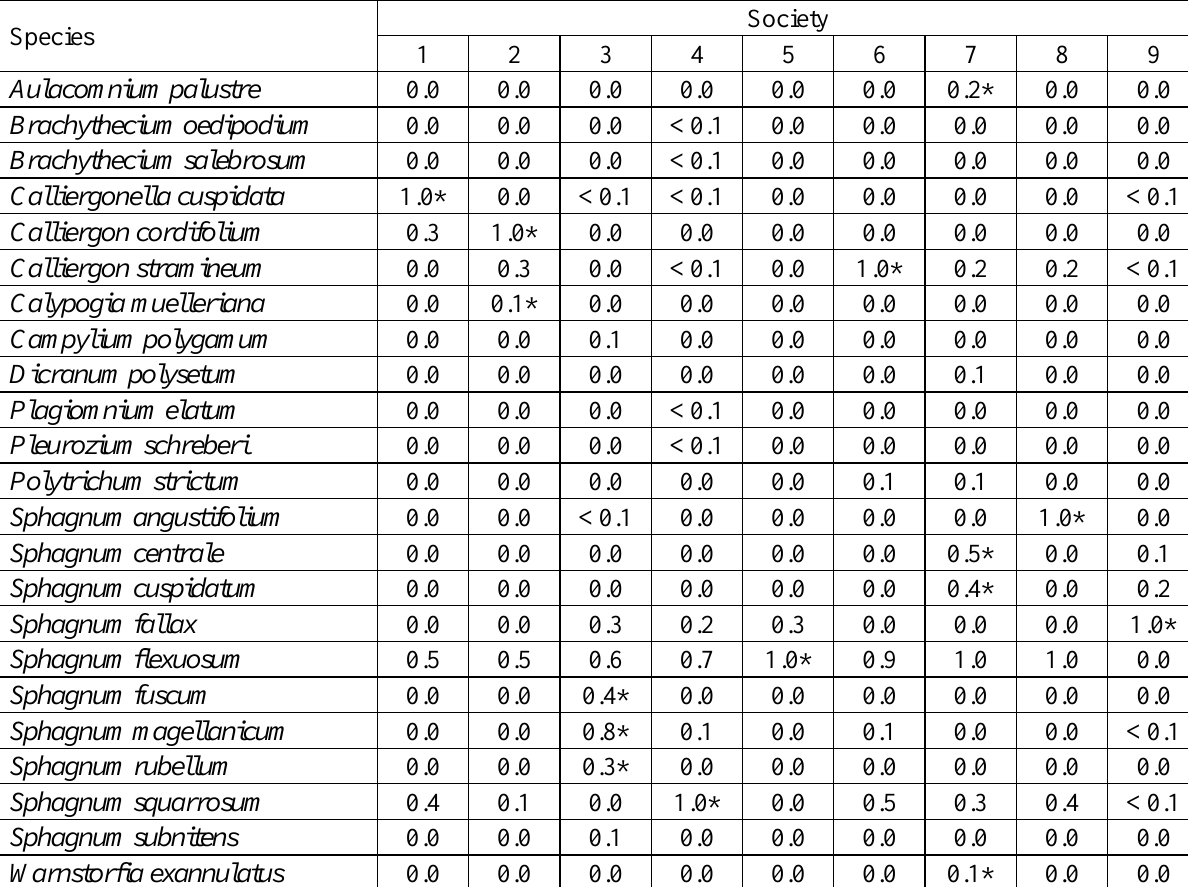
Table 3. Centroids (species frequency) of bryophyte societies and their significant (p ≤ 0.05) indicator species (marked with